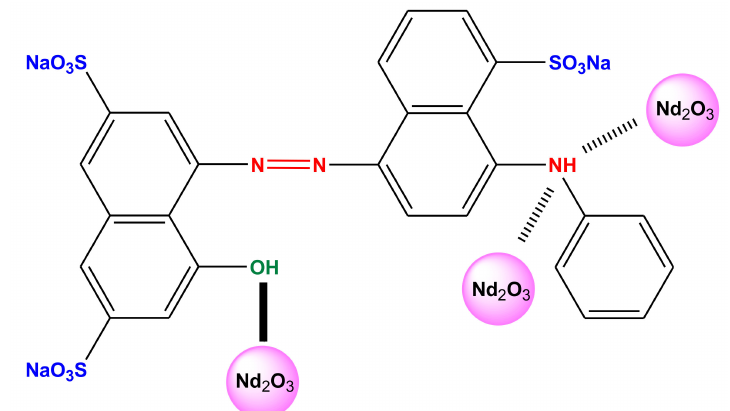
Figure 4. Proposed adsorption mechanism of AB92 and Nd 2 O 3 nanoparticles.